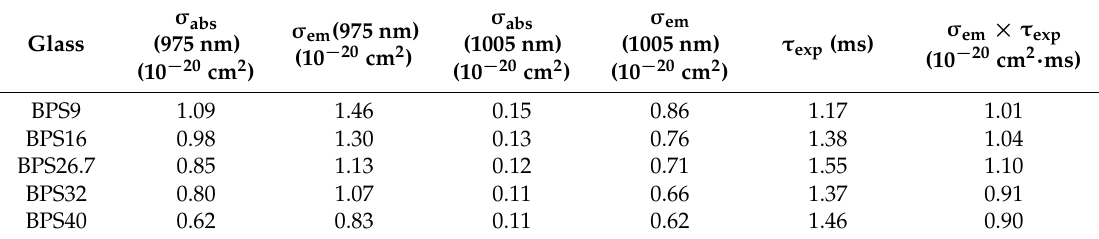
Figure 2. The fluorescence decay curve of Yb 3+ -doped 20BaO-(80- x )P 2 O 5 - x SiO 2 -1Yb 2 O 3 ( x = 9, 16, 26.7, 32, and 40 mol %, respectively) glasses. Table 1. Spectral parameters for 20BaO-(80- x )P 2 O 5 - x SiO 2 -1Yb 2 O 3 (BPS x ) ( x = 9, 16, 26.7, 32, and 40 mol %, respectively) glass samples.